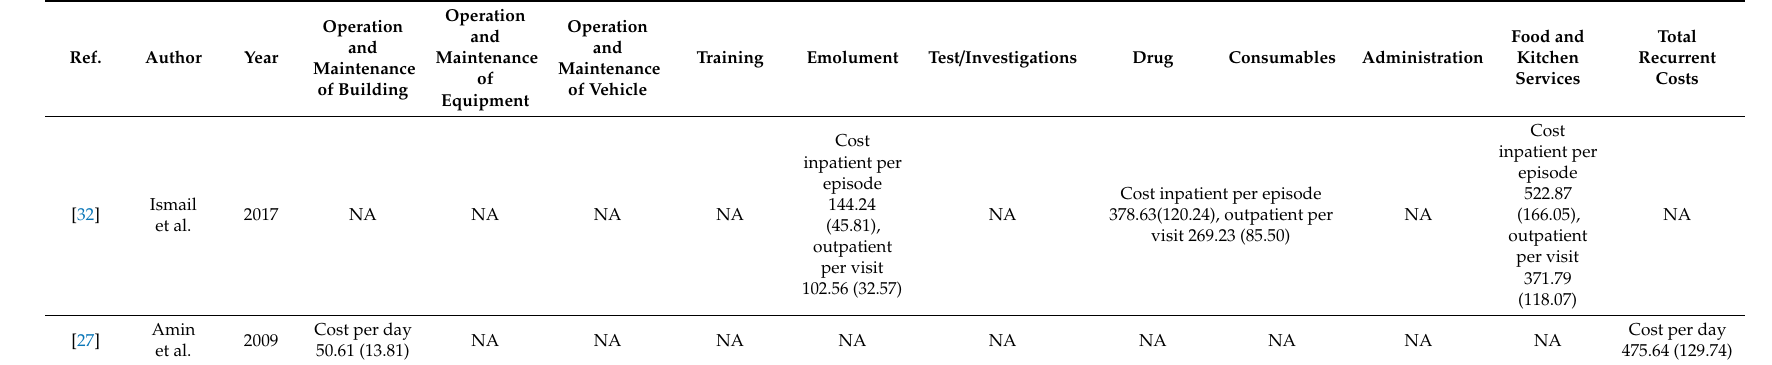
Table 5. Costing costs, estimates per person and total costs in studies reporting recurrent costs of diabetes individuals.